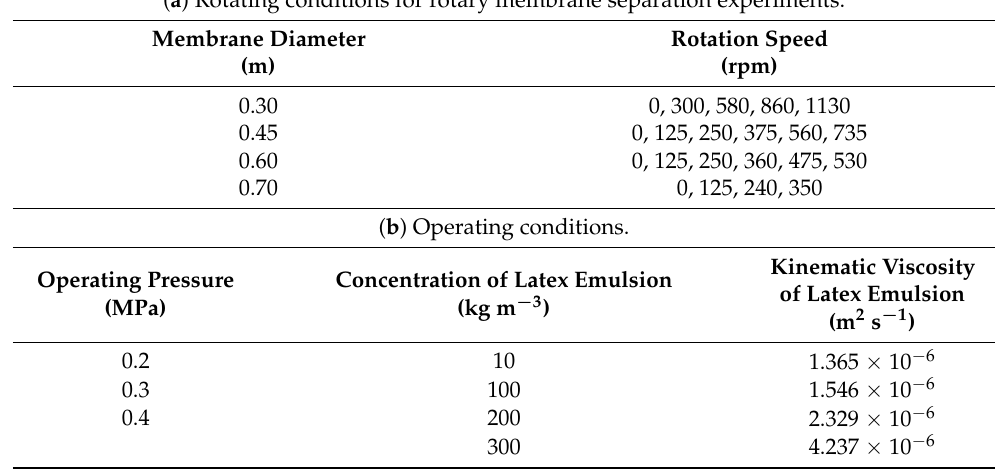
Table 1. Experimental conditions. ( a ) Rotating conditions for rotary membrane separation